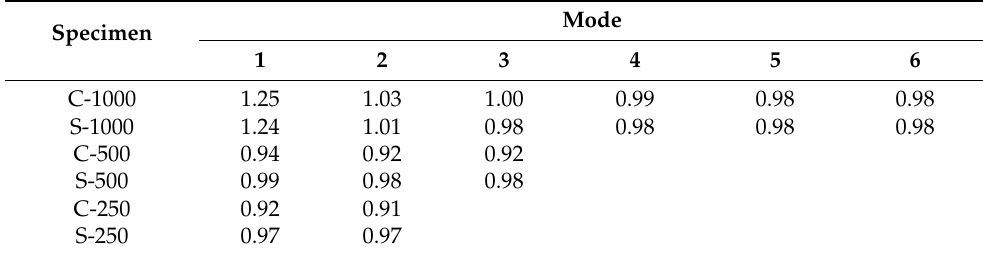
Table 15. Ratios between experimental and analytical frequencies.